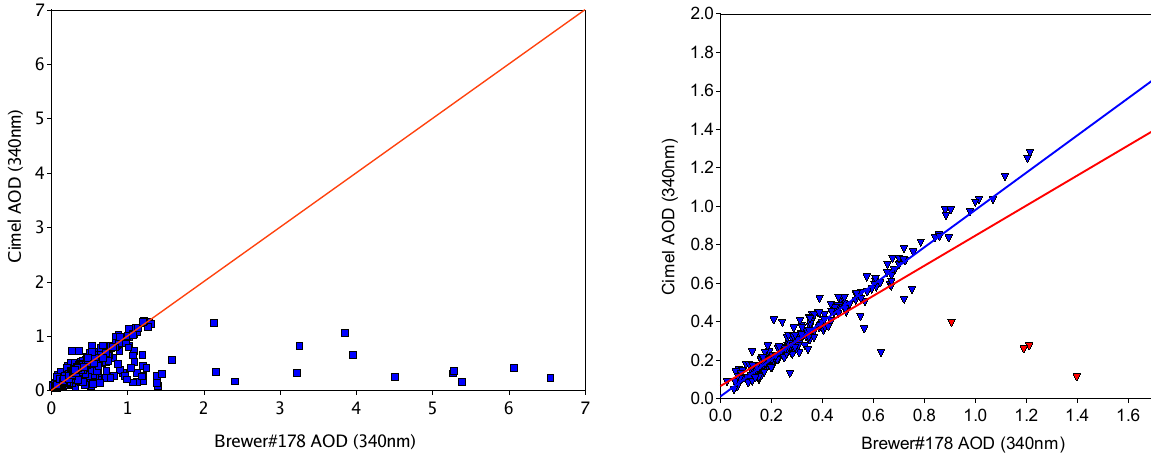
Fig. 3. Comparison of the Brewer and Cimel AOD values at 340nm (time period for the comparison is 3min). The red curve ( f (x) = 0 . 781 x + 0 . 065) represents the regression line of all the data. The blue curve ( f (x) = 0 . 968 x + 0 . 011) shows the regression line of the data without the